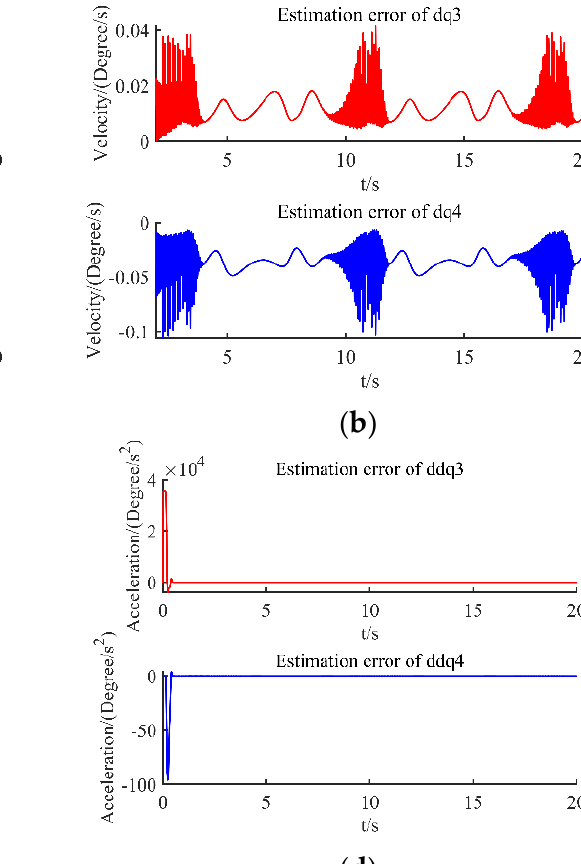
x Figure 2. ( a ) State x 2 estimation; ( b ) State x 2 estimation errors; ( c ) State x 3 estimation; ( d ) State x 3 Figure 2. ( a ) State 2 estimation; ( b ) State 2 estimation